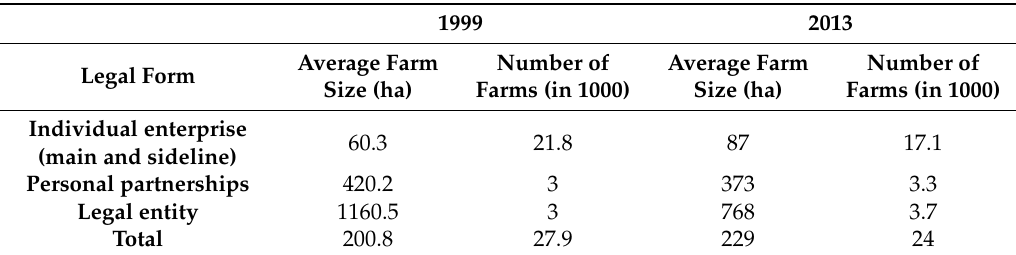
Table 1. Agricultural enterprises in Germany. Based on